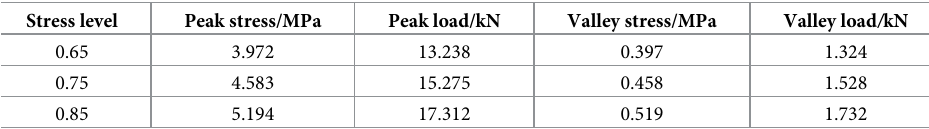
Table 4. Single-stage cyclic load for fatigue